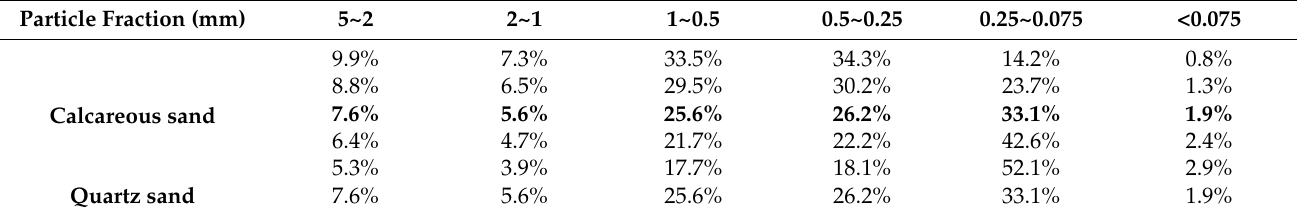
Table 1. Test grain size distribution of the calcareous sand and quartz